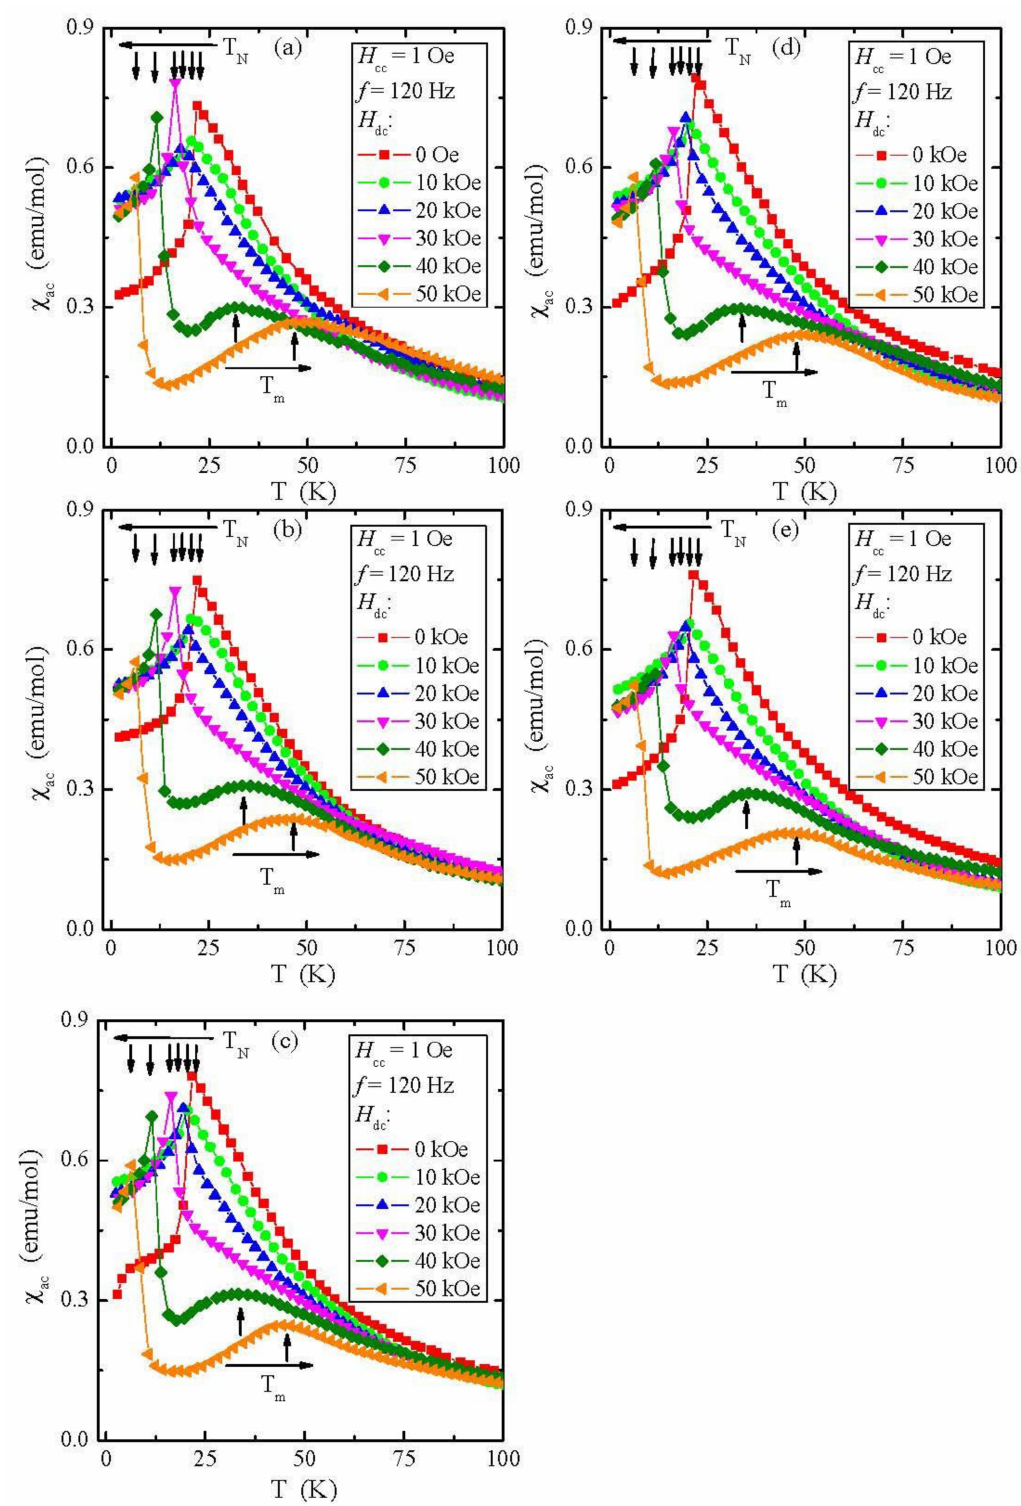
Figure 9. Ac magnetic susceptibility χ ac vs. temperature T recorded at internal oscillating magnetic field H ac = 1 Oe with internal frequency f = 120 Hz for the ZnCr 2 Se 4 single crystals doped with Pb 2+ ions having contents of 0.06 ( a ), 0.07 ( b ), 0.09 ( c ), 0.11 ( d ), and 0.12 ( e ) taken at external magnetic fields H dc = 0, 10, 20, 30, 40, and 50 kOe. Vertical arrows indicate the N é el T N and T m temperatures, and horizontal ones indicate the shift of T N and T m with increasing magnetic field H dc